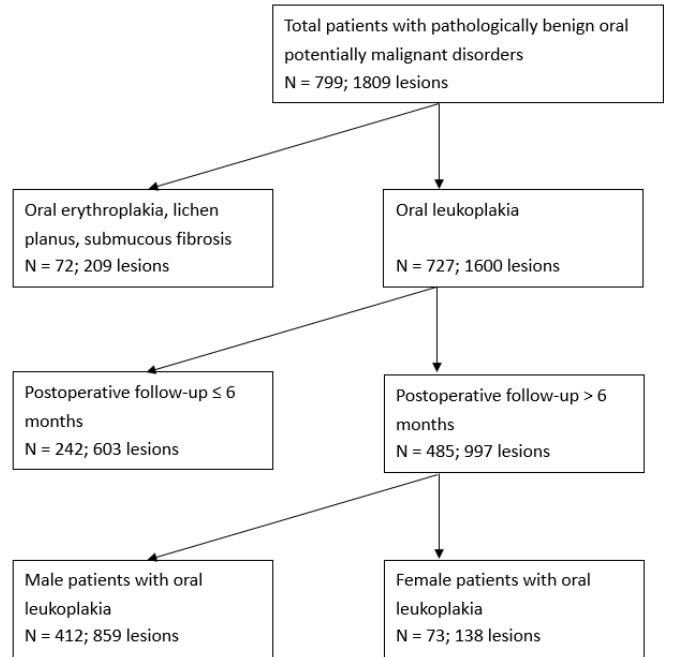
Figure 1. Flow chart of the cohort study demonstrating the number of participants under various screening criteria and conditions. Number of the patients (N) and lesions were shown. Since more than 1 lesion was recorded in patients with multifocal disease, the numbers of total lesions were more than the numbers of total patients.